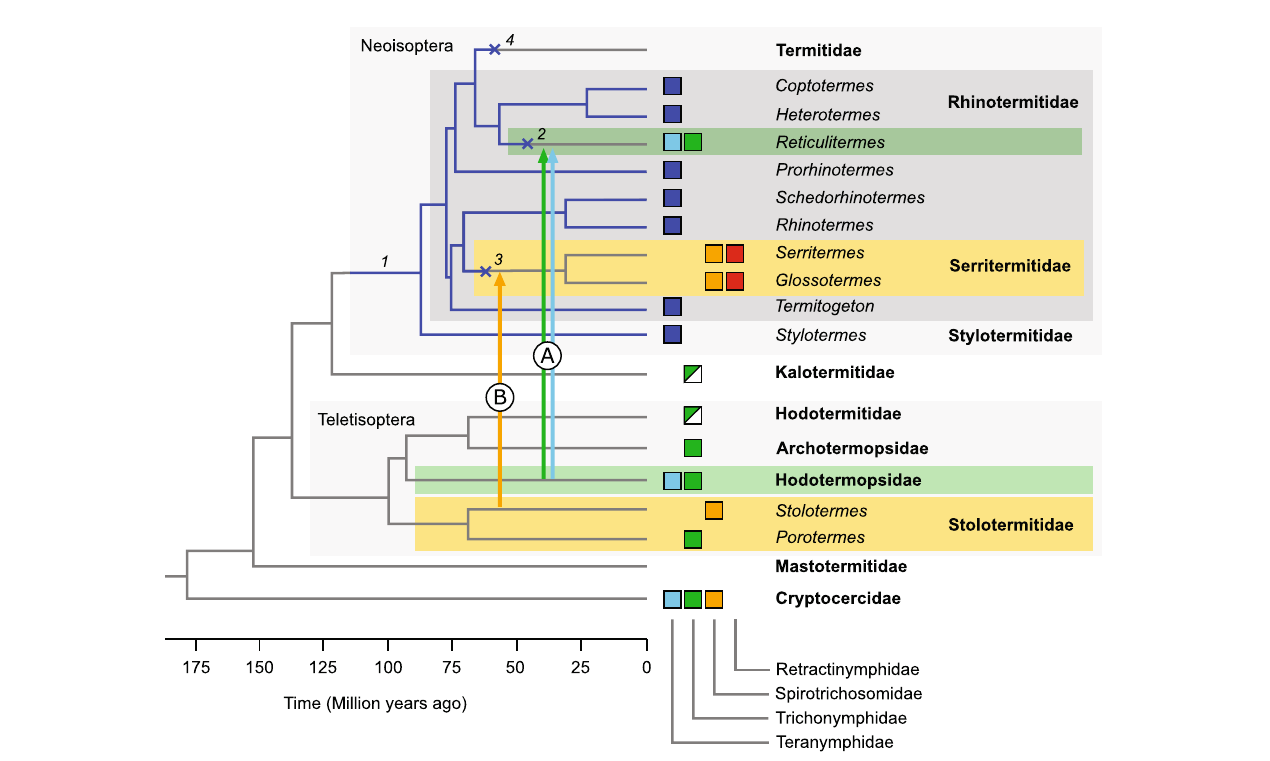
FIGURE 6 Evolutionary history of Trichonymphida in Neoisoptera. Boxes indicate the occurrence of a particular flagellate family in a termite genus (same colors as in Figure 4). We propose that a member of the genus Pseudotrichonympha was present already in the common ancestor of Neoisoptera (1) and subsequently cospeciated with its host (blue edges). The lineage was lost (×) several times during host evolution (2–4). Arrows indicate horizontal transfer events that led to the acquisition of Trichonymphidae and Teranymphidae in Reticulitermes (A) and of Spirotrichosomidae in Serritermitidae (B) . The origin of Retractinymphidae is unclear. The host phylogeny (schematic) is based on Bucek et al. (2019) and Wang et al.